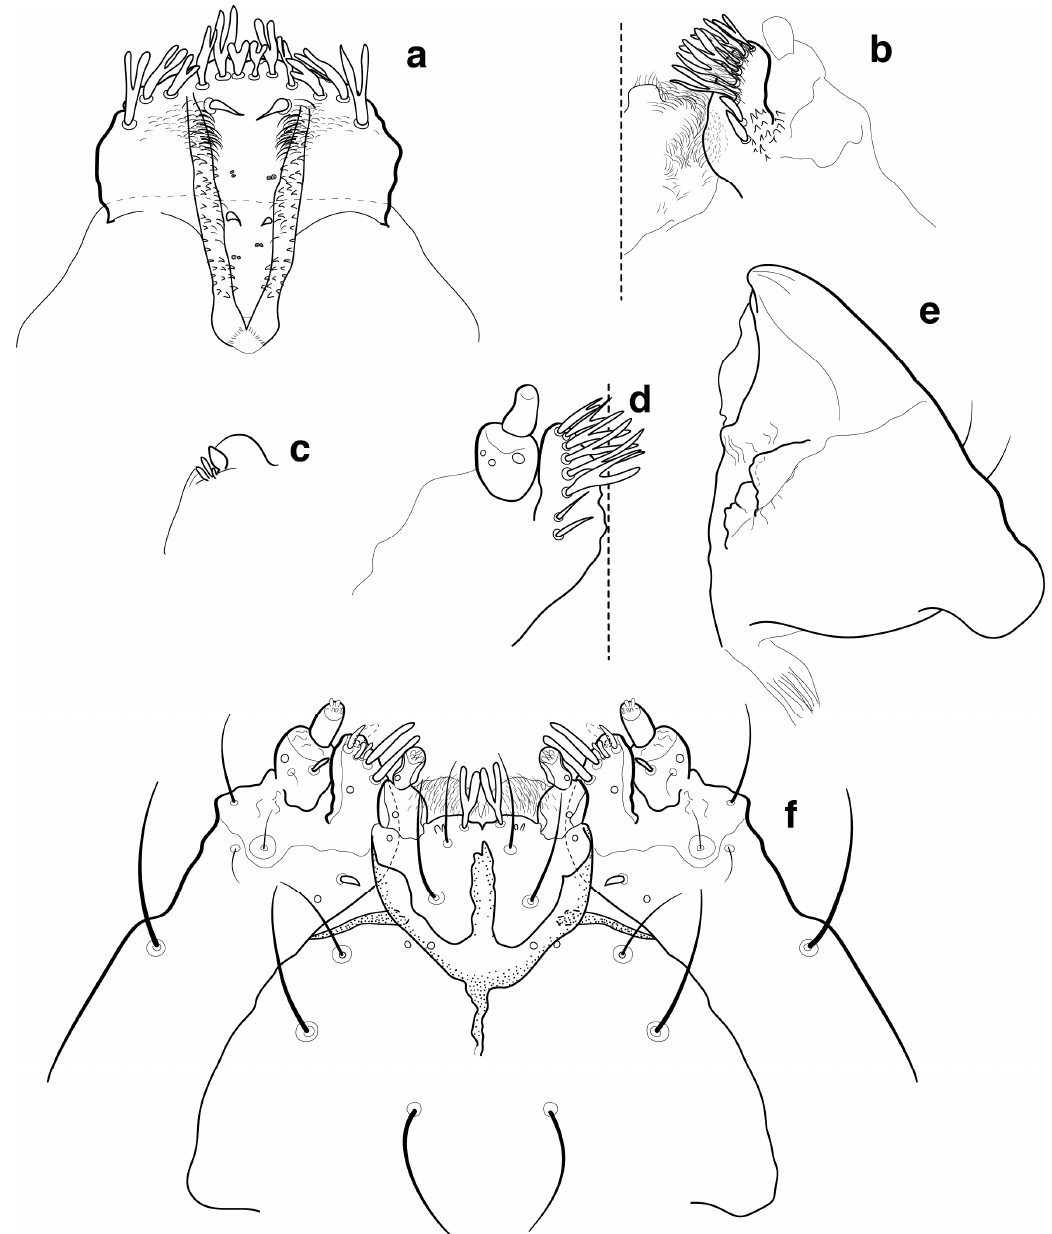
Figure 63. Eucalandra setulosa mouthparts: ( a ) epipharynx; ( b ) mala and hypopharynx, dorsal view; ( c ) antenna, lateral view; ( d ) detail of mala and maxillary palp, ventral view; ( e ) mandible; and ( f ) labio-maxillary complex, ventral view.